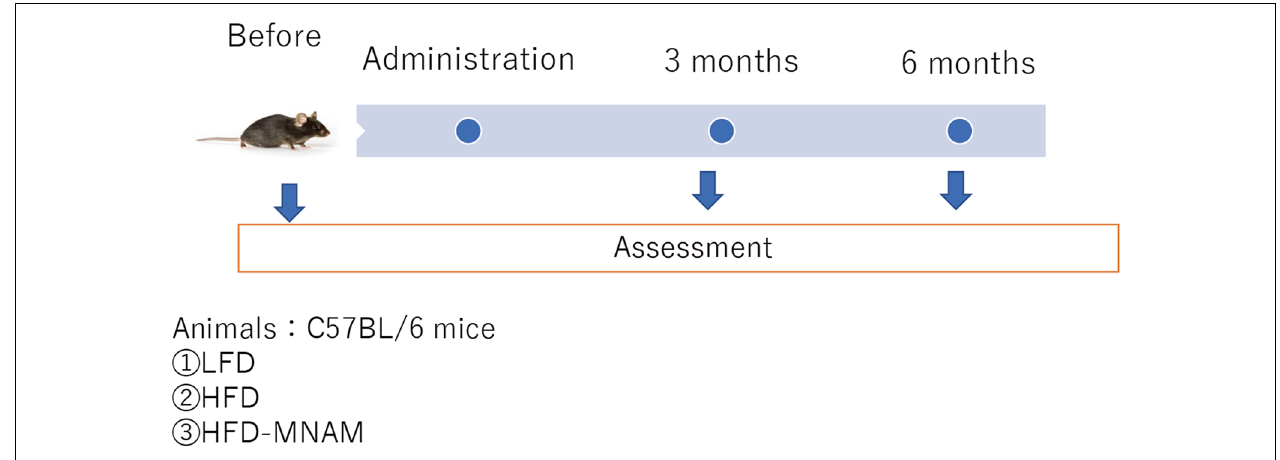
FIGURE 2 | Schedule of experiments. LFD, low-fat diet; HFD, high-fat diet; HFD-MNAM, high-fat diet plus 1% N 1